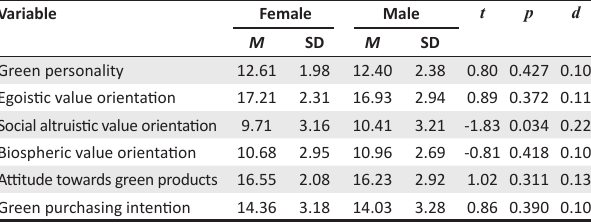
Among the predictor variables, age, marital status and biospheric and egoistic value orientations had a statistically non-significant effect. On the other hand, green personality, attitude towards green products and social altruistic value orientation had a significant influence. The predictive effect of the preceding variables was in the following descending order: social altruistic value orientation, B = 0.39, t (102) = 4.46, p < 0.001; green personality, B = 0.33, t (102) = 2.57, p = 0.012; and attitude towards green products, B = 0.24, t (102) = 2.26, p = 0.026. Table 5 presents the results of the multiple regression analysis.